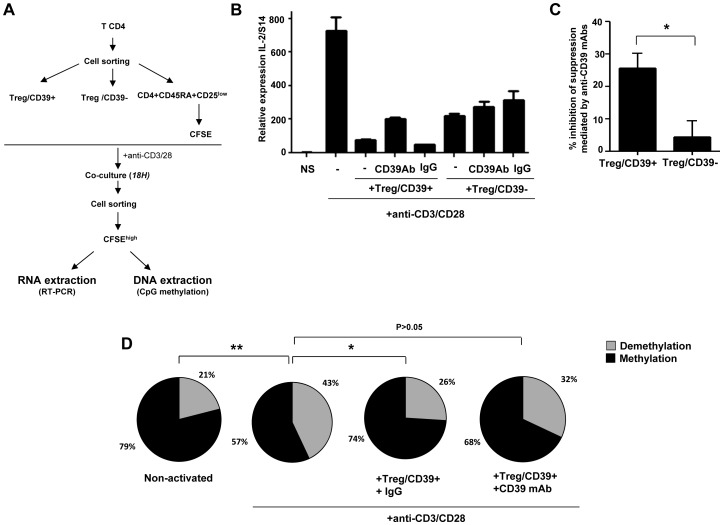
Treg inhibit IL-2 production via the CD39 pathway.(A) Using CD39 cell surface expression, Treg/CD39+ and Treg/CD39− were sorted and co-cultured with CFSE labeled CD4+CD45RA+CD25low naive T cells (ratio ½). After overnight anti-CD3/CD28 (1 µg/ml) activation, CFSE naive T cells were resorted from co-culture and the impact of Treg on IL-2 production was evaluated by q-PCR. (B) A representative Figure of 3 independent experiments showing Treg/CD39+ suppression of IL-2 mRNA expression in anti-CD3/CD28 stimulated naive CD4+ cells. (C) Effect of anti-CD39 mAbs on suppressive function of Treg/CD39+ and Treg/CD39−. (D) The epigenetic changes on methylation of the unique specific CpG site of il-2 gene promoter (n = 3) were studied by bisulphite modification of a mixture of DNA of anti-CD3/CD28 (1 µg/ml) activated naive T cells alone or co-cultured with Treg/CD39+ or Treg/CD39− in 3 independent experiments. Following molecular cloning and bulk sequencing, 20–30 colonies were analyzed for each experimental condition. *P<0.05, **P<0.01.